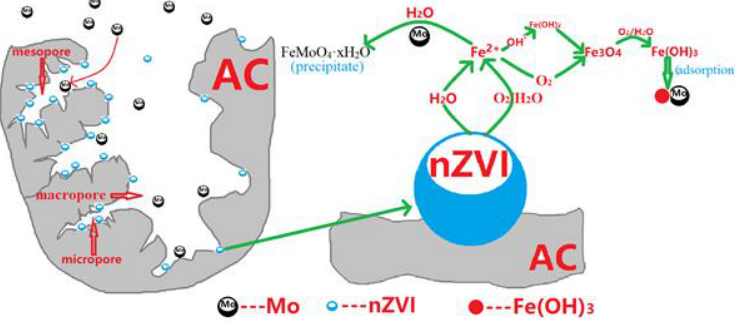
Figure 6. Proposed mechanism of removal of Mo(VI) from water by NZVI /